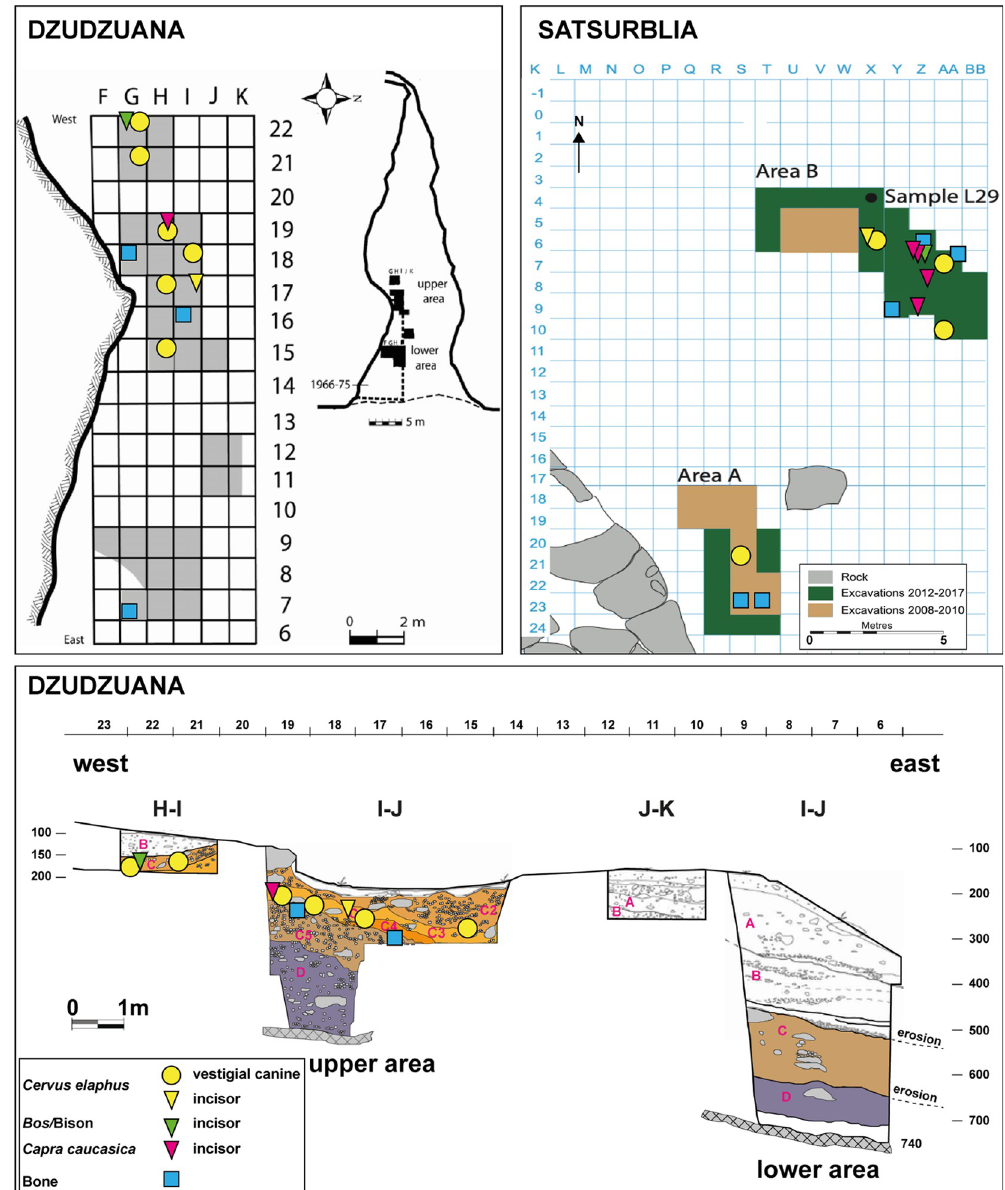
Fig 2. Spatial distribution and stratigraphic location of pendants from Dzudzuana and Satsurblia. On the left, spatial distribution (top) and stratigraphic location (bottom) of pendants from Dzudzuana Cave (red deer canines = yellow circles; red deer incisor = yellow triangle; caprid incisor = magenta triangle; bone pendants = blue square) plotted over the West– East sections. On the right, the Satsurblia Cave pendants spatial distribution.